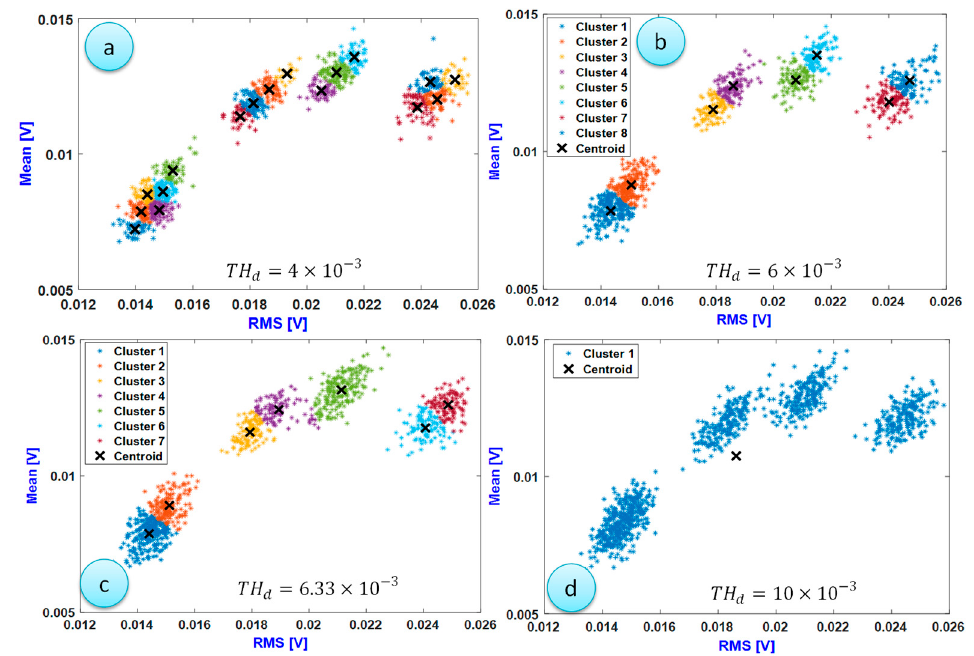
Figure 16. Clustering results with different threshold distance TH d and a fixed persistence number N = 10. ( a ) TH d = 4 × 10 − 3 ; ( b ) TH d = 6 × 10 − 3 ; ( c ) TH d = 6.33 × 10 − 3 ; ( d ) TH d = 10 × 10 − 3 .